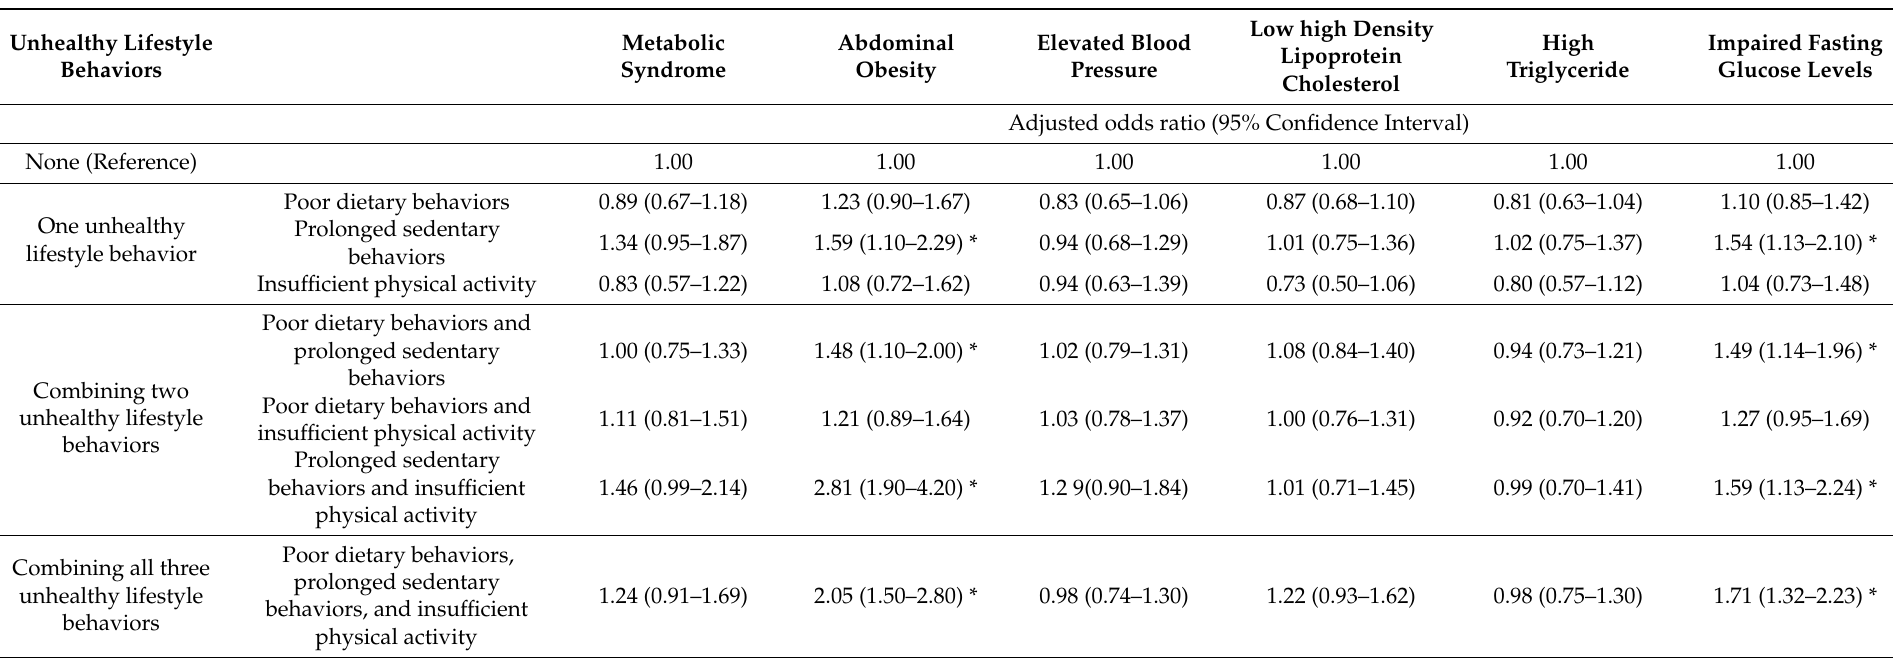
Table 2. Combined Effects of Unhealthy Lifestyle Behaviors on Metabolic Syndrome among Postmenopausal Women ( N =